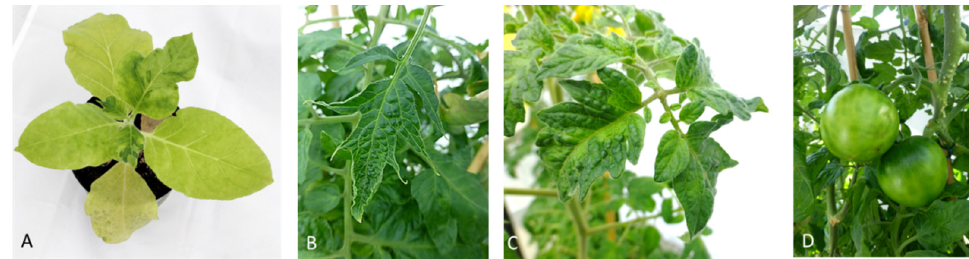
Figure 1. ( A ) TMV symptoms on Nicotiana tabacum cv. ‘Samsum nn‘, showing leaf distortion, mosaic pattern and chlorosis; ( B – D ) ToBRFV symptoms on tomatoes showing mosaic pattern, leaf narrowing and rugose spots on fruits.